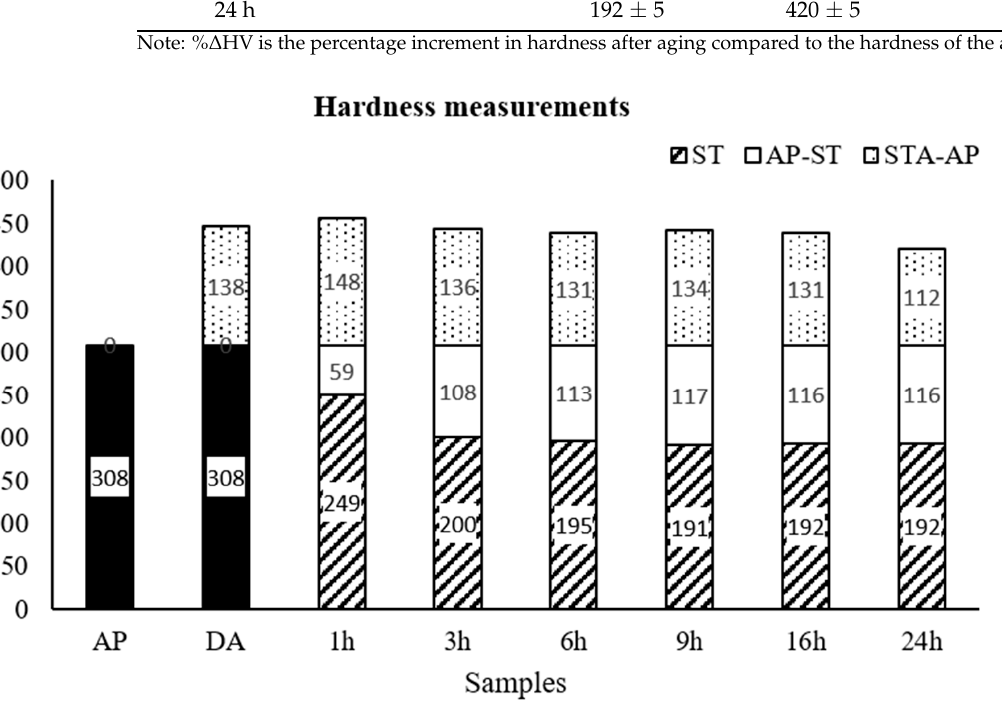
Figure 11. Average Vickers hardness: The black bar represents the hardness of the as-printed sample. The patterned bars show the hardness after ST, whereas the white bars represent the amount of hardness that decreased due to ST. The dotted bars represent the increment in hardness relative to AP after aging. The increment in hardness due to the hardening precipitates is the sum of the white and dotted bars. The numbers in the bars are the average values of the hardness in HV.